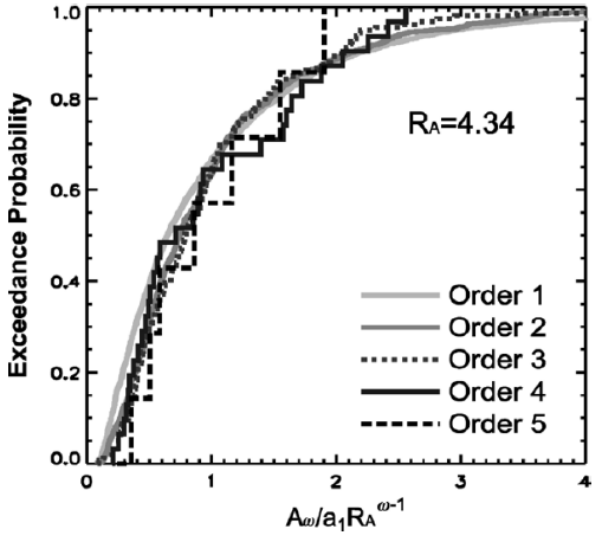
Figure 8. Reproduction of the original figure of Mantilla and Gupta (2005, Fig. 2) showing the statistical scaling of the probability dis- tribution of drainage area with order (generalized Horton law) of the river network in the Whitewater basin, Kansas,